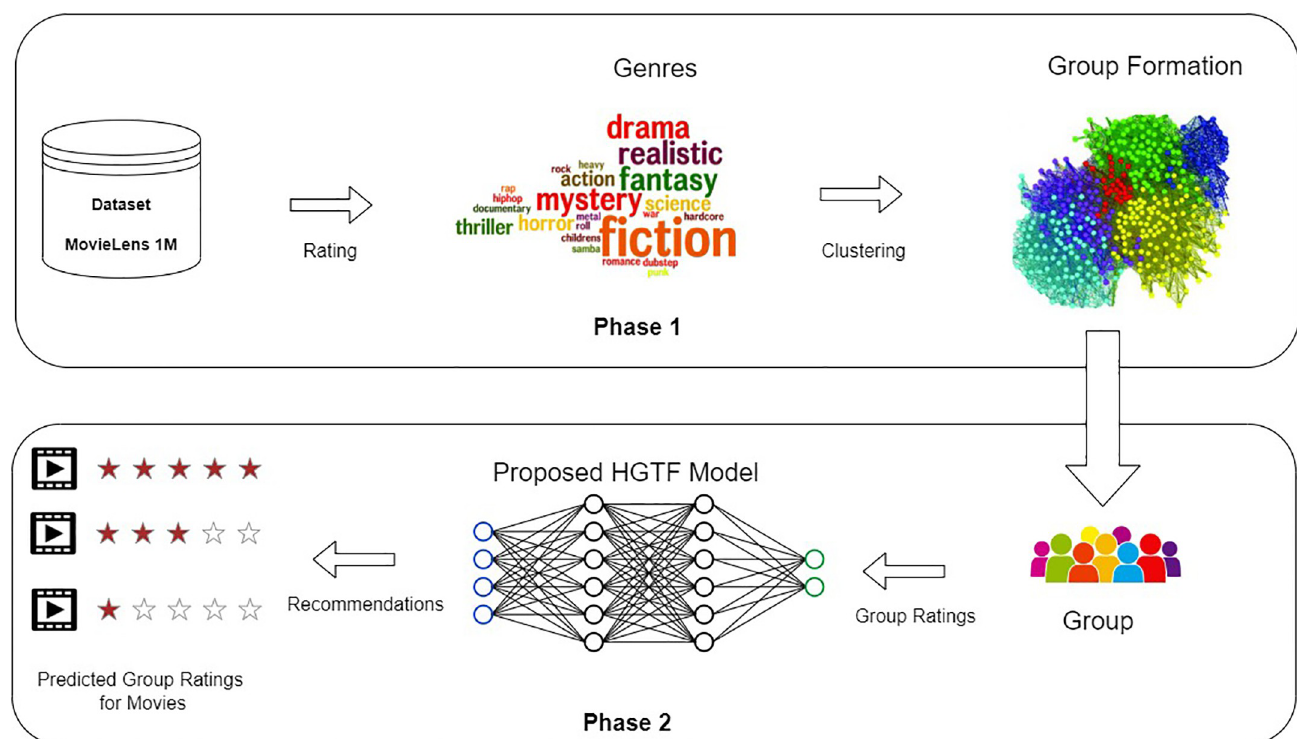
Fig 1. Group recommender